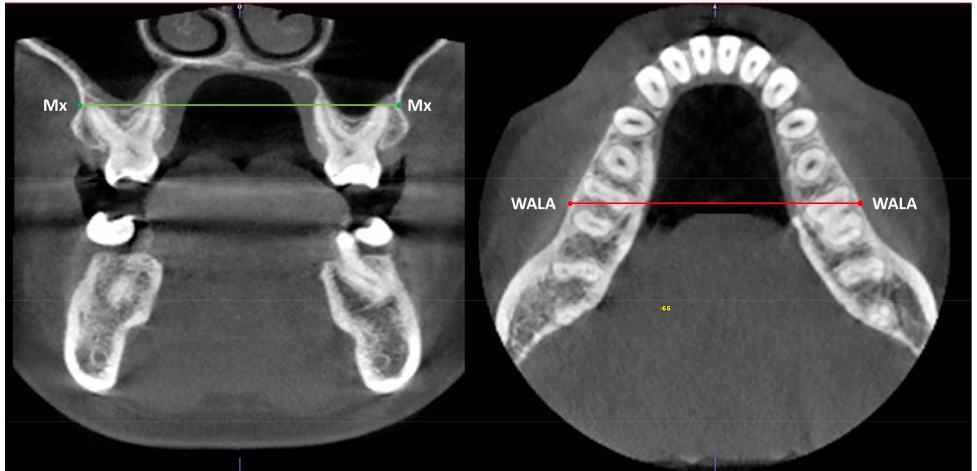
Figure 1. Maxillomandibular transverse skeletal discrepancy